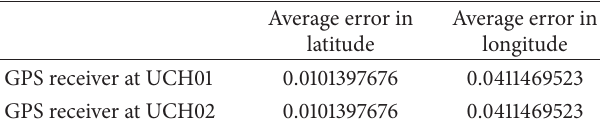
Table 6: Average error on correct 1.